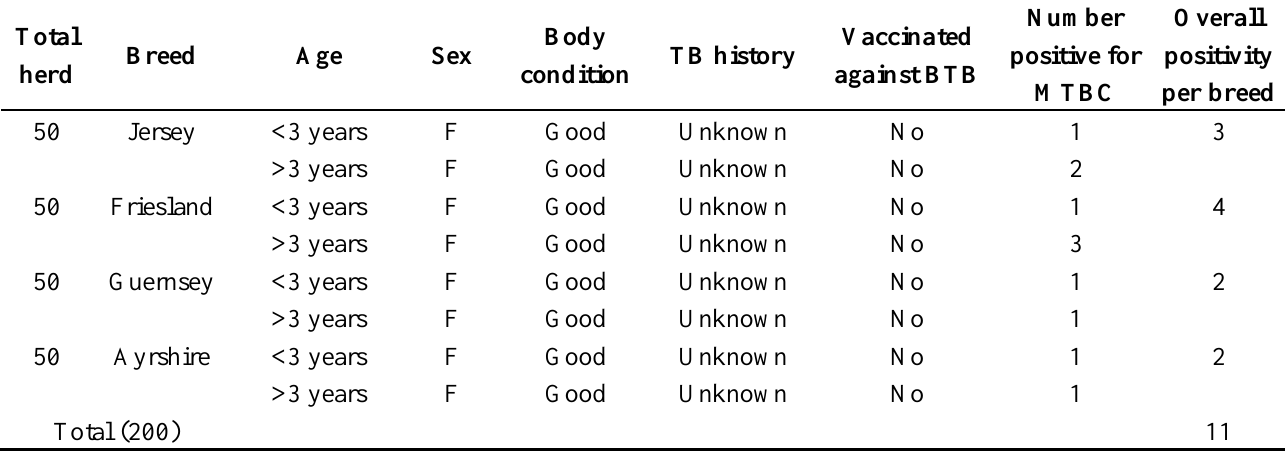
Table 1. Characteristics of cows that tested positive for